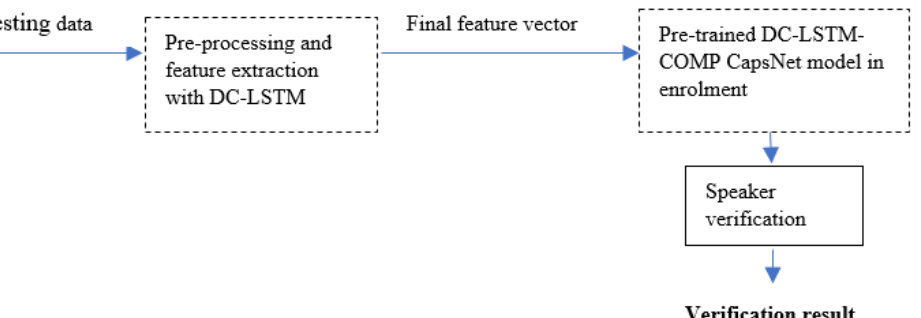
Figure 5. Block diagram of speaker verification of the proposed DC-LSTM-COMP CapsNet model in the evaluation phase.